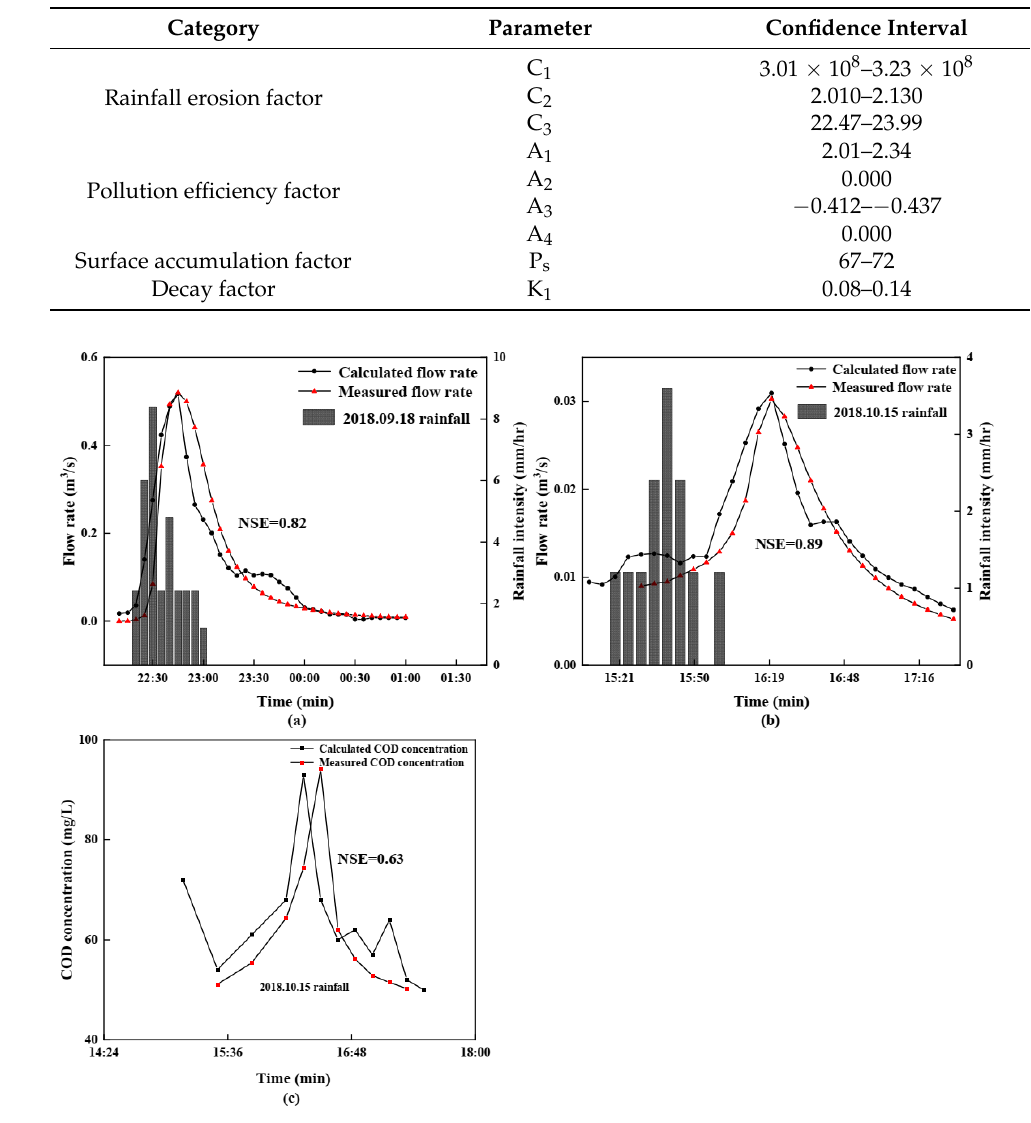
Figure 3. Model validation and calibration: ( a ) hydraulic model validation; ( b ) hydraulic model calibration; ( c ) water quality